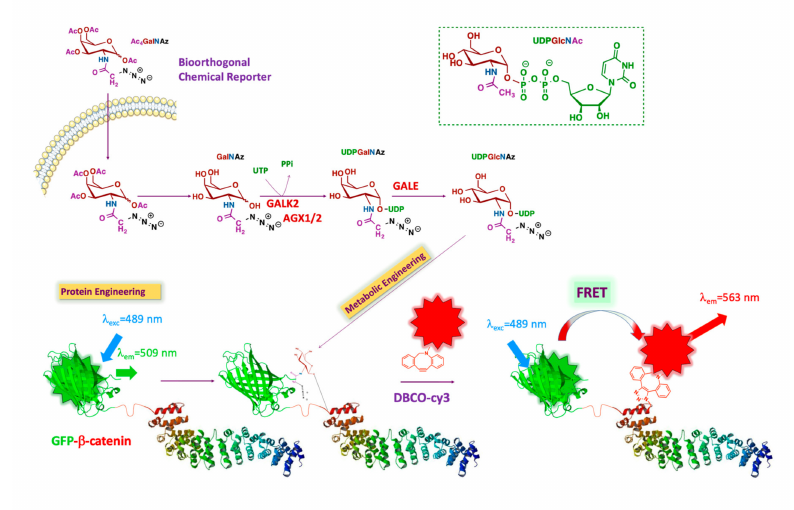
Figure 1. Schematic representation of the strategy: FRET-based imaging of dual-labeling of protein and glycans. FRET, Förster resonance energy